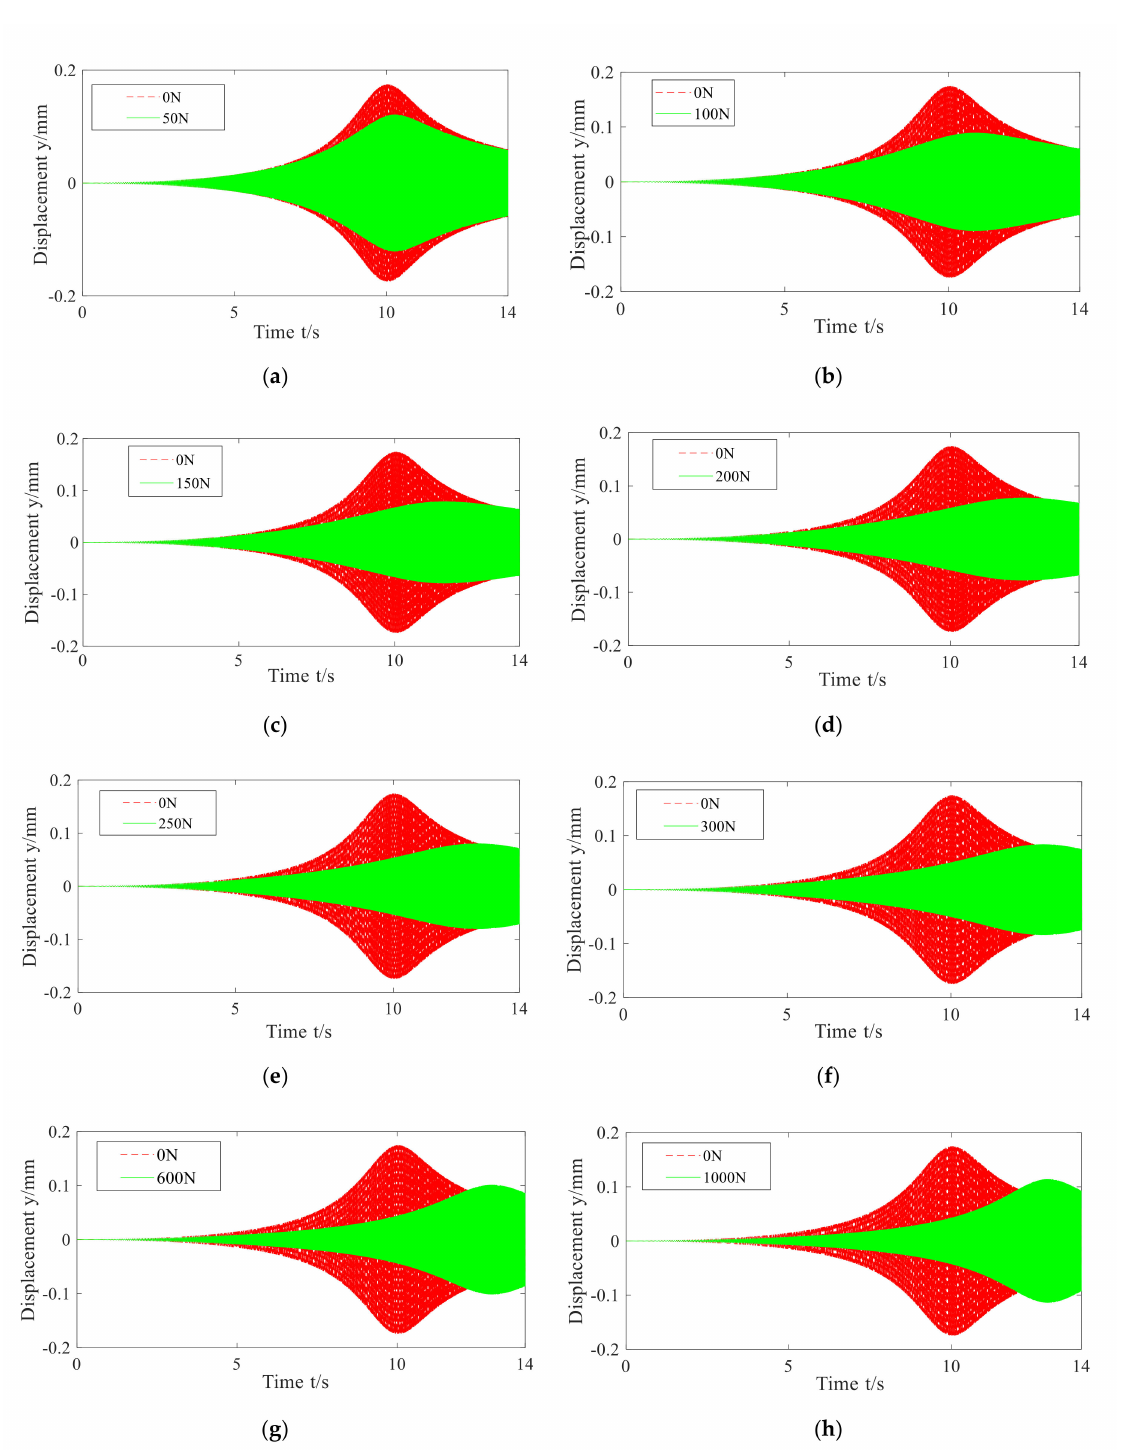
Figure 21. Response of shaft system under ( a – h ) fixed control forces, respectively 50 N, 100 N, 150 N, 200 N, 250 N, 300 N, 600 N and 1000